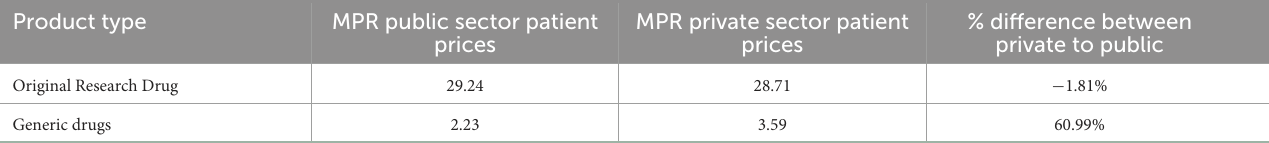
TABLE 5 MPRs for medicines found in both public and private